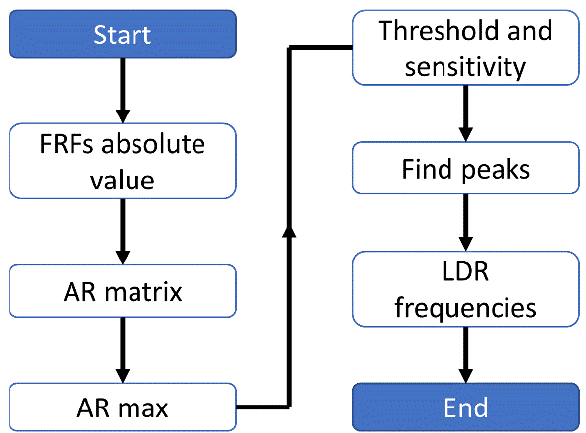
Figure 2. The flowchart of the automated LDR extraction algorithm.